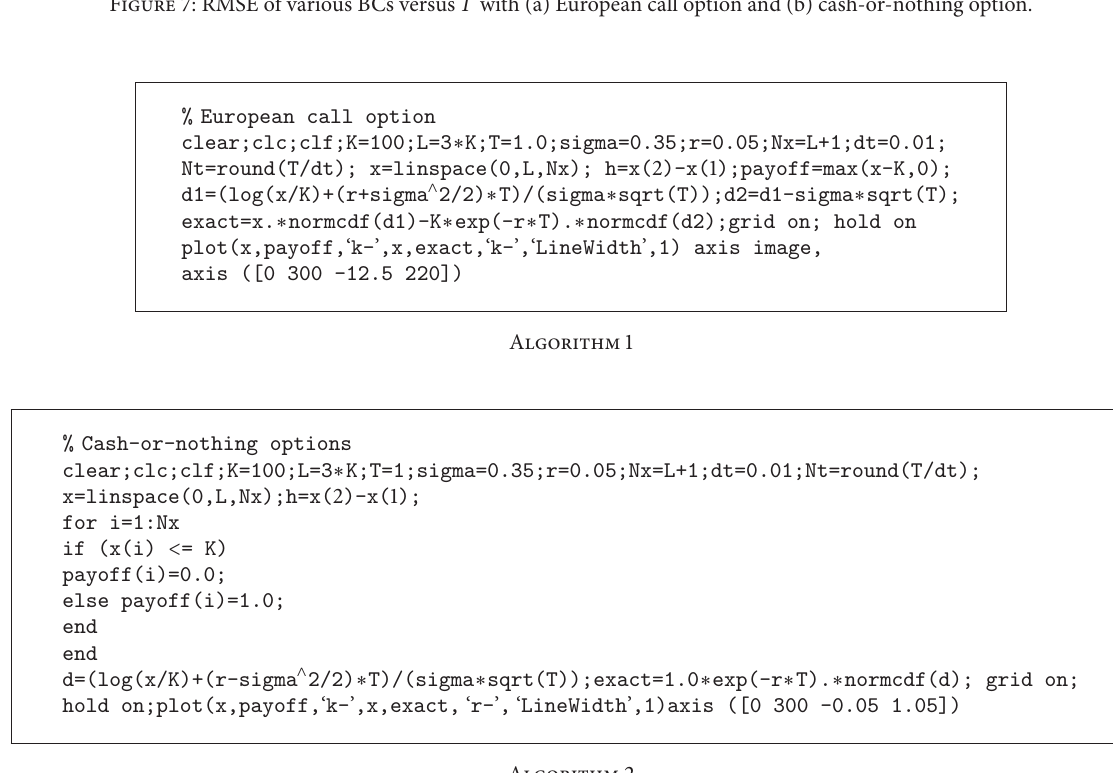
Figure 7: RMSE of various BCs versus 𝑇 with (a) European call option and (b) cash-or-nothing